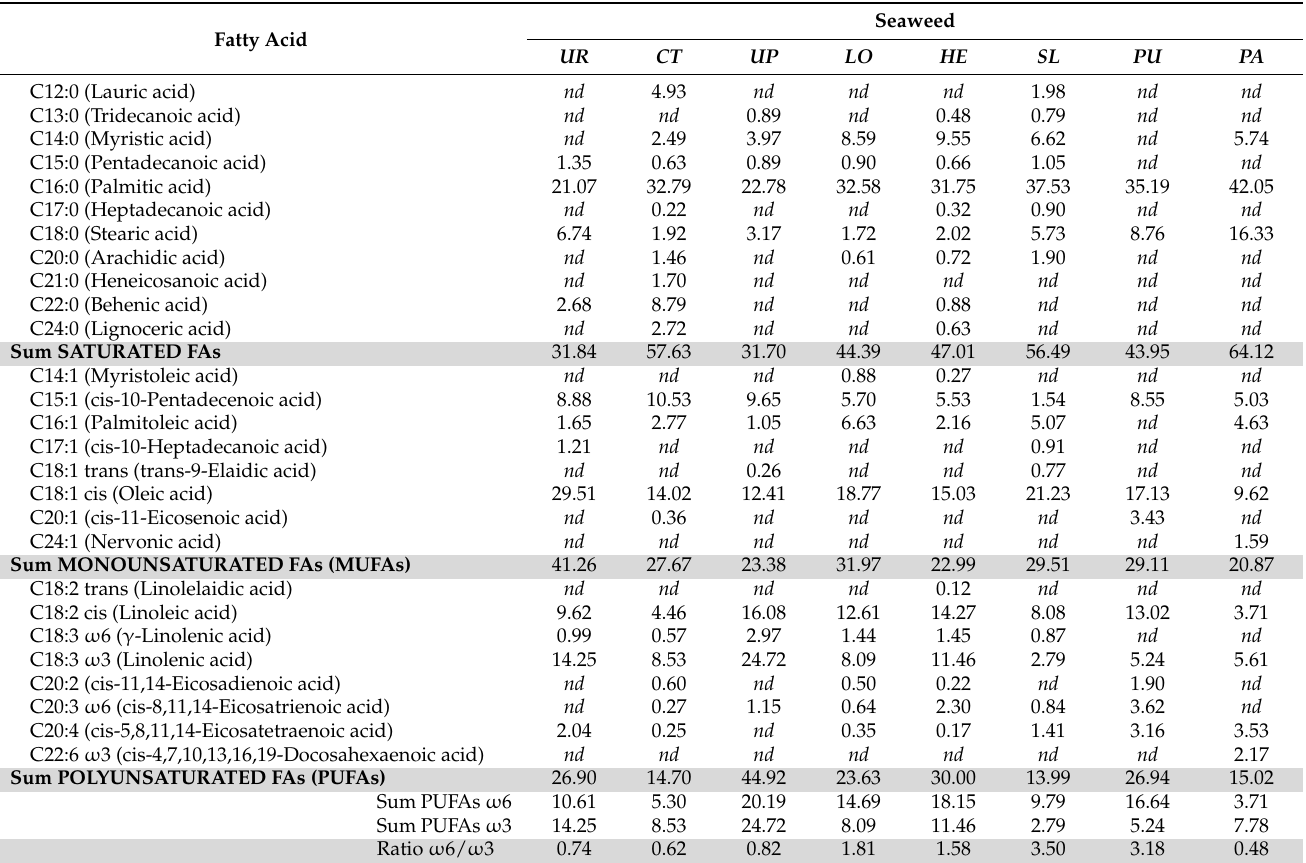
Table 2. Fatty acid content of the studied seaweeds (% of total fatty acid